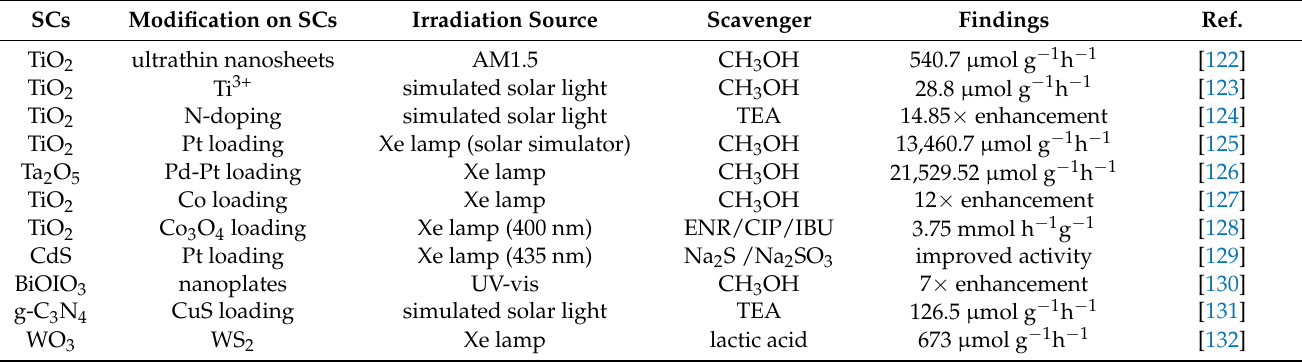
Table 3. Examples of 2D photocatalysts for photocatalytic hydrogen evolution. SCs Modification on